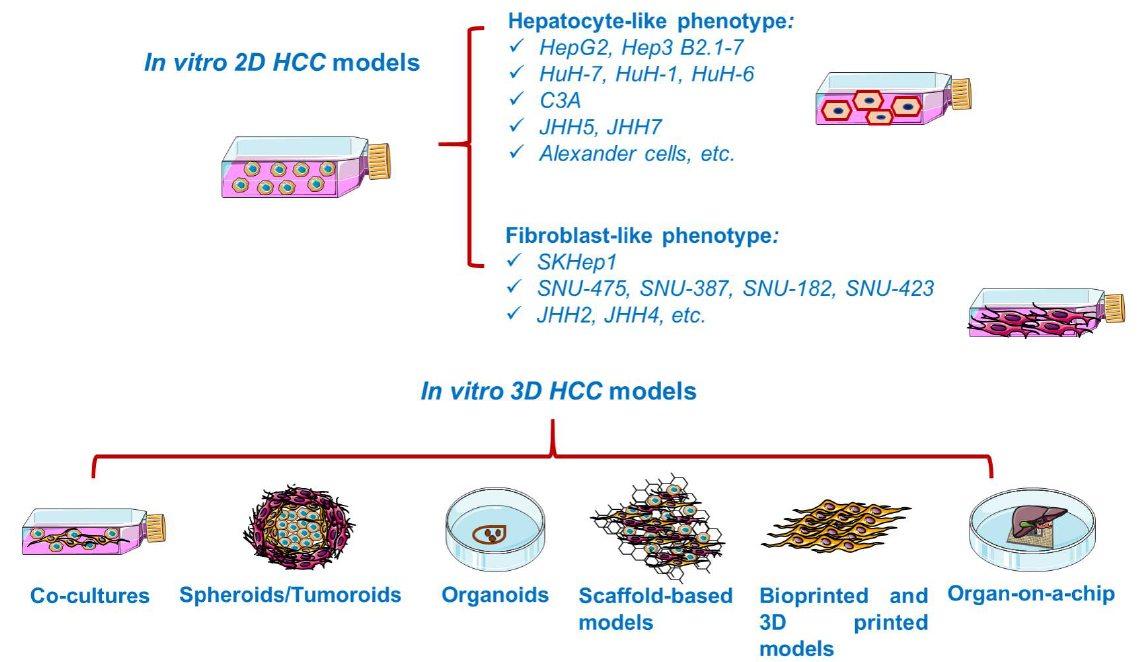
Figure 3. Overview of the in vitro established models for HCC. This image contains Servier Medical Art elements, which are licensed under a Creative Commons Attribution 3.0 Unported License; https://smart.servier.com accessed on 20 June 2021.